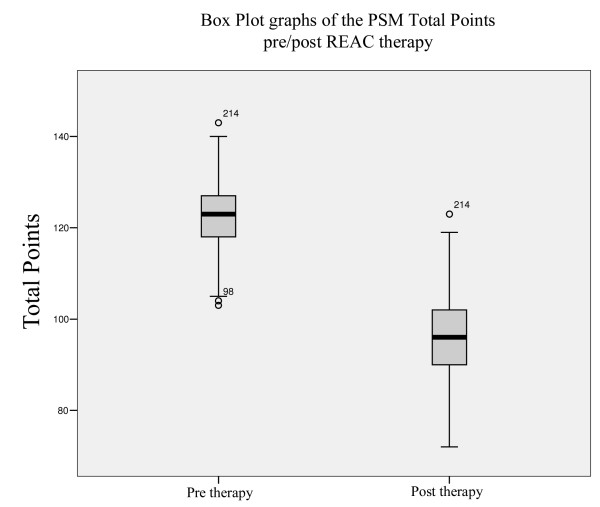
Box Plot Graphs (treated). Box Plot Graphs of the PSM total points of the real treatment.